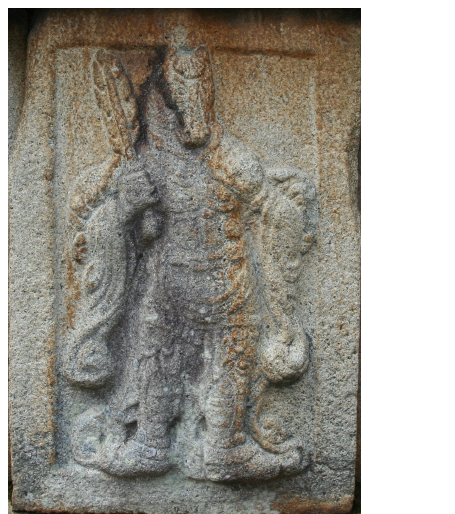
Figure 13. The cosmological disposition of the twelve animals found at diverse tumuli in Korea. The hour of the rat is midnight (north), and the hour of the horse is noon (south). The order segues from right to left and top to bottom in each inclined column. The Chinese characters for every branch are given.